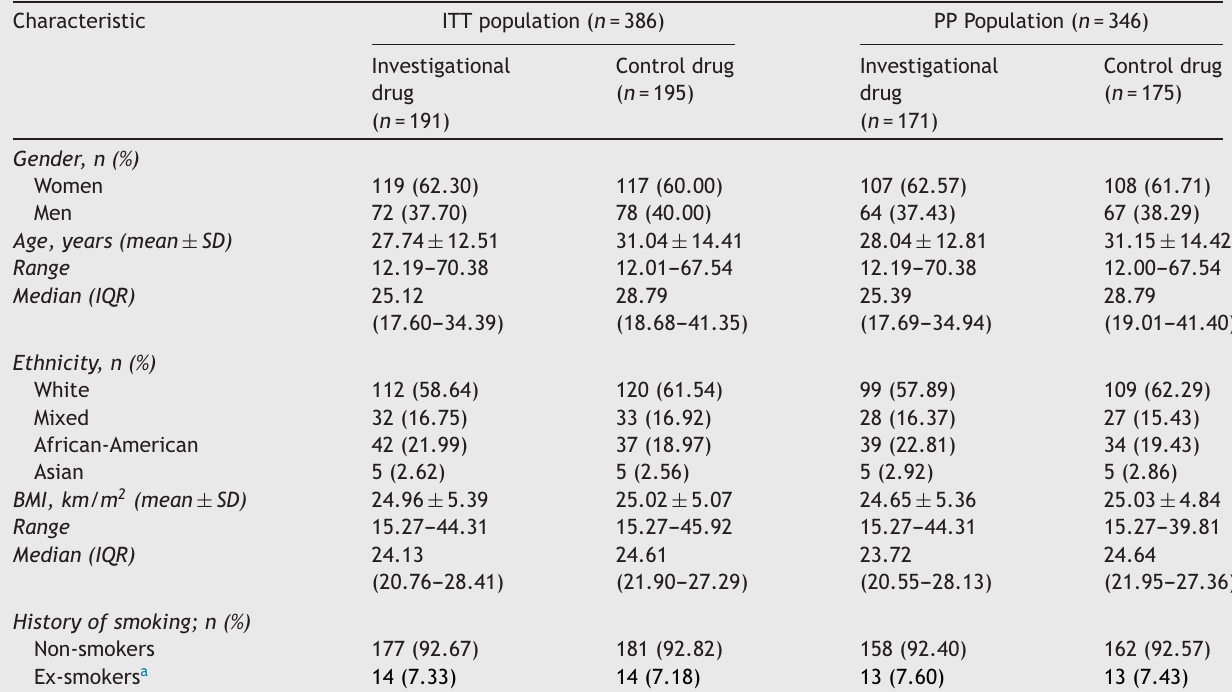
Flow of patients in the study (ITT, intent to treat population; PP, per-protocol population; RV, randomization visit). Demographic characteristics of the ITT and PP